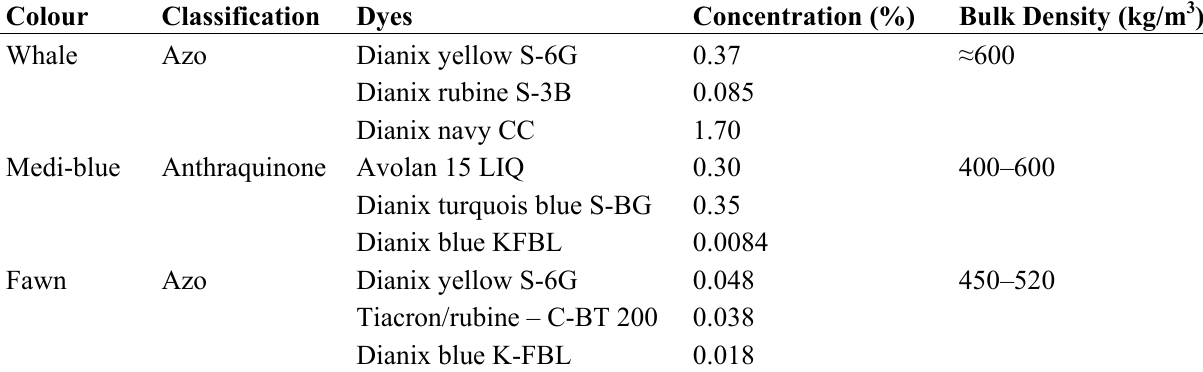
Table 1. Chemical properties of the textile dyes used in this